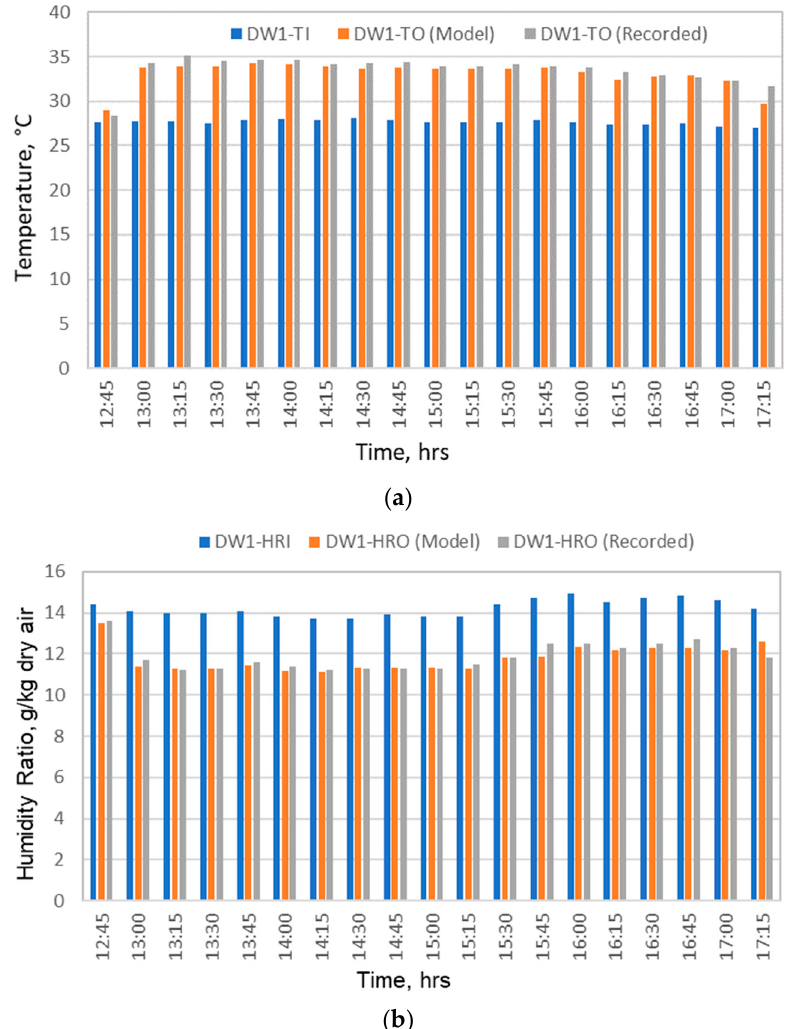
Figure 4. ( a ) Modelled and recorded values of ( a ) temperature across desiccant wheel (DW1) for day I, and ( b ) modelled and recorded values of humidity ratio across desiccant wheel (DW1) for day I.